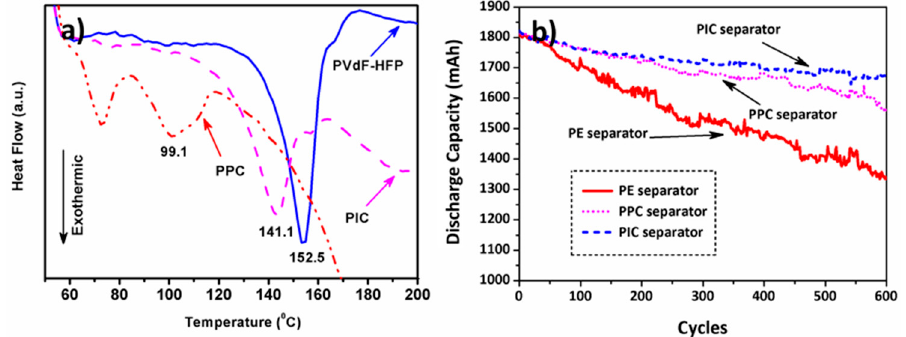
Figure 3. Differential scanning calorimetry (DSC) curves ( a ) and cycle performance ( b ) of PE separator, PPC separator, and PIC separator.